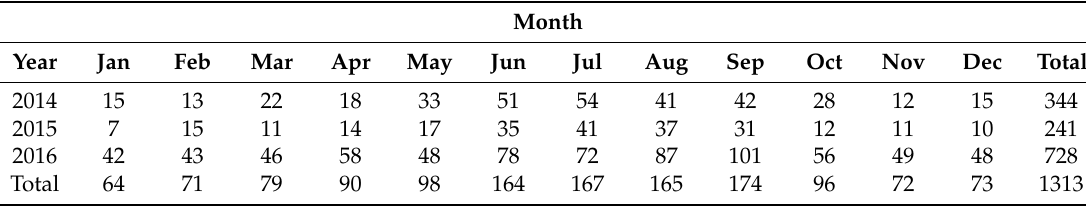
Table 6. Monthly frequency of the noise